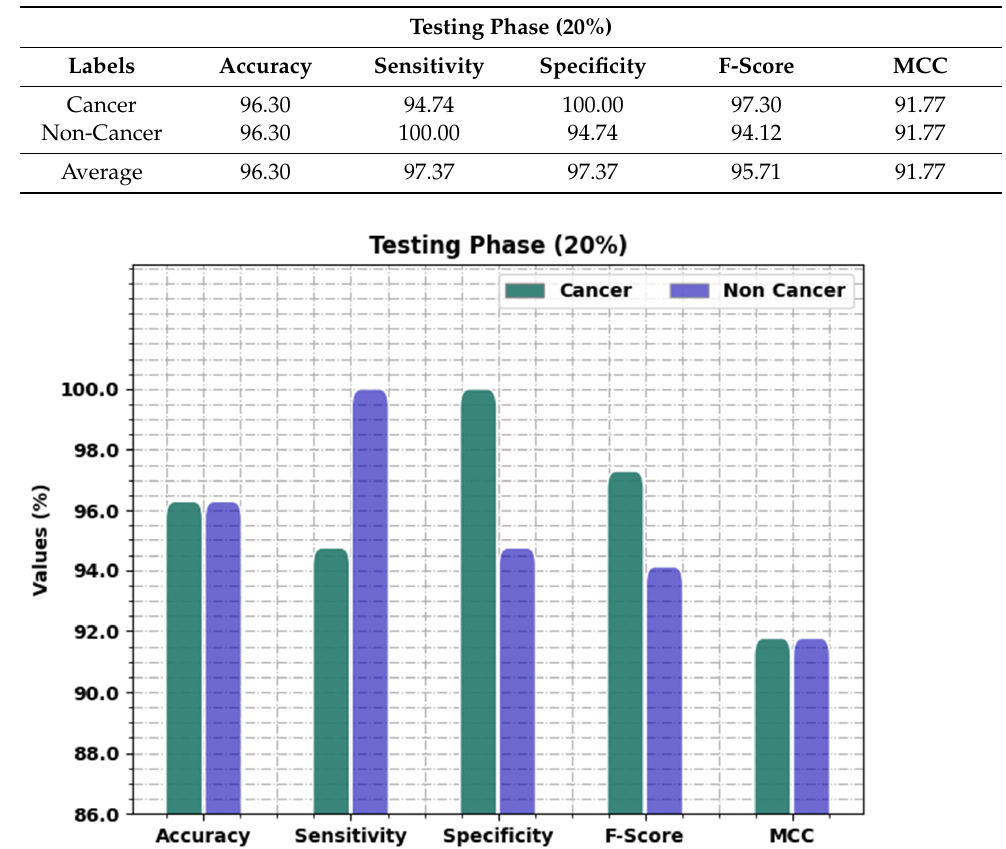
Figure 5. Result analysis of OIDCNN-OPMDD approach under 20% of TS data. Table 3. Result analysis of OIDCNN-OPMDD approach with distinct class labels under 20% of TS data.